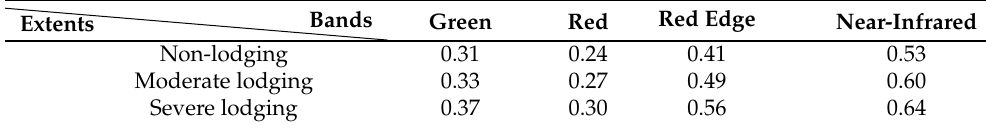
Table 2. The average reflectance with three lodging extents in different